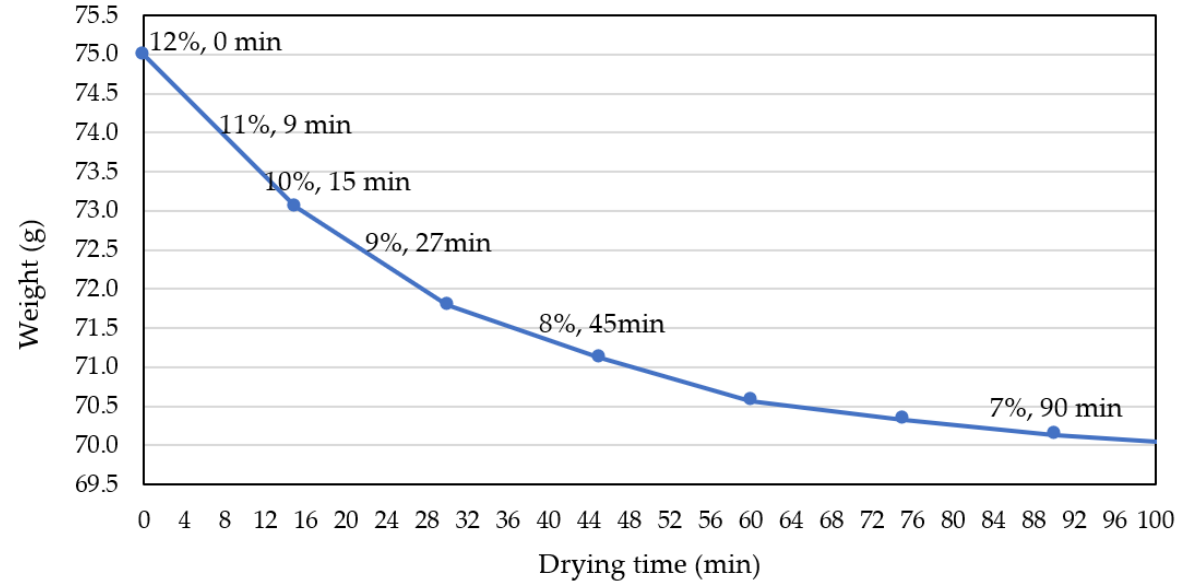
Figure 1. Weight change of red pepper powder according to drying time and calculated moisture